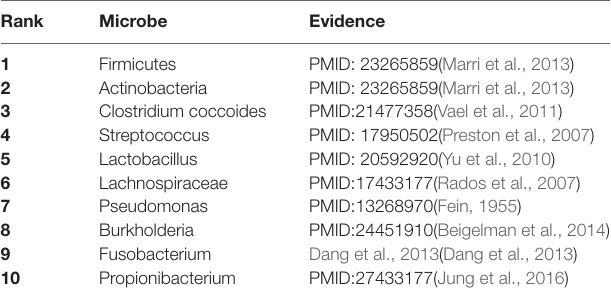
TABle 3 | The Asthma-related microbe prediction of KATZBNRA. All of top 10 microbes were confirmed by recent studies.